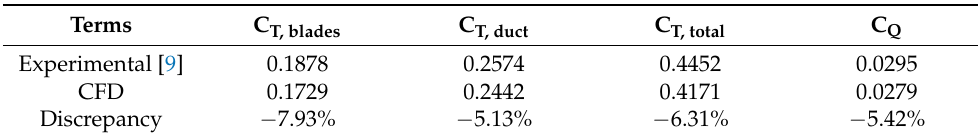
Table 2. Comparison between CFD results of medium mesh and experimental values; Grunwald’s model in hovering.